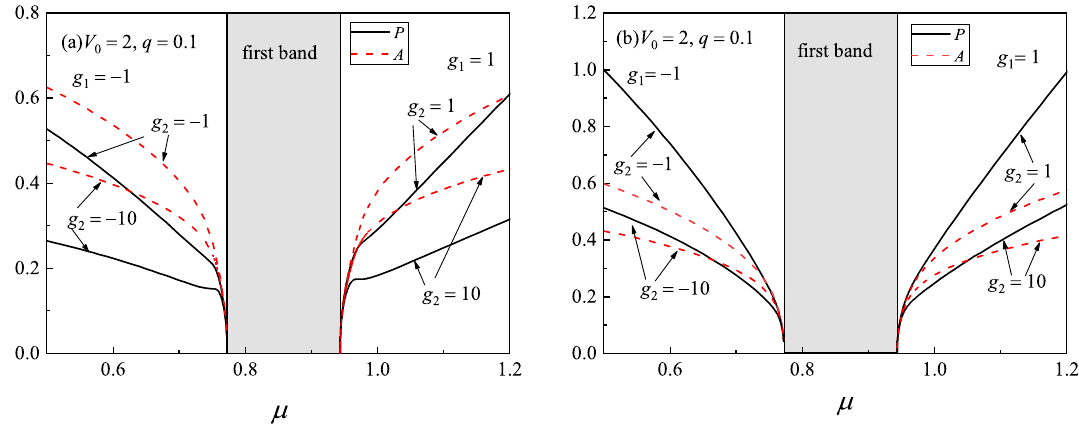
Figure 1. Amplitude (dashed lines) and power (solid lines) curves of gap solitons bifurcated from the first Bloch band. ( a ) on-site gap solitons. ( b ) off-site gap